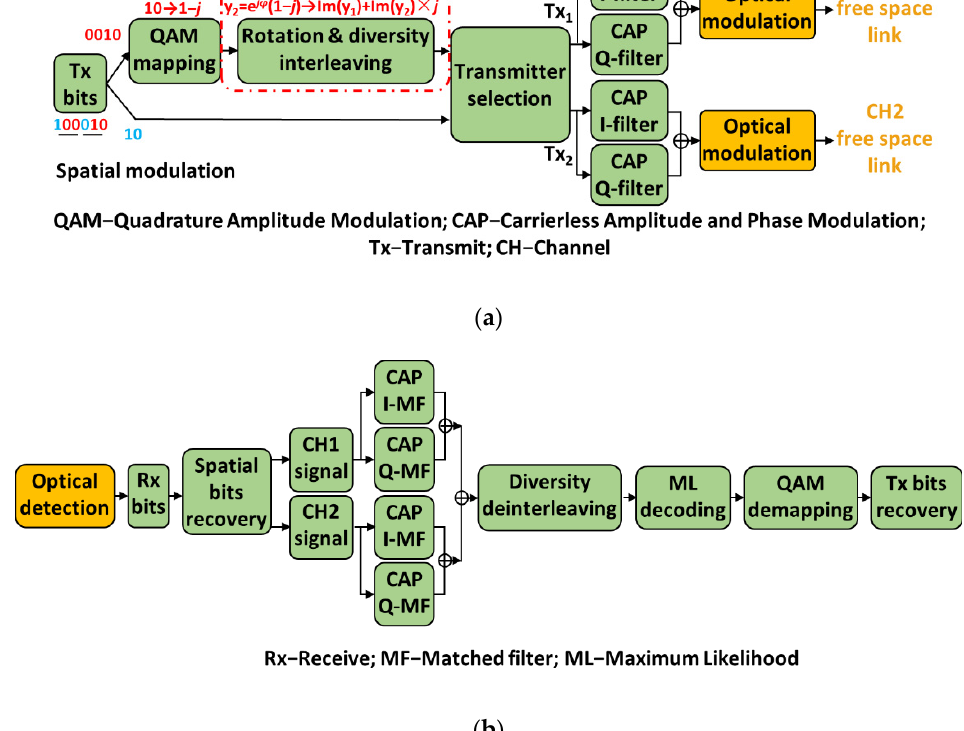
Figure 2. Block diagram of the SSD scheme incorporated with SM. ( a ) Signal generation; ( b ) signal detection.